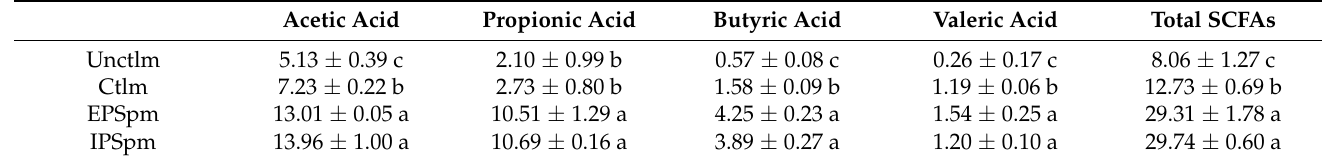
Table 3. Short chain fatty acid (SCFA) production (mM) after fecal fermentation with Cs-4 EPSp and IPSp (5 mg/mL). Unctlm: fecal fermentation basal medium before fecal fermentation. Ctlm: fecal fermentation basal medium after fecal fermentation; EPSpm: EPSp after fecal fermentation; IPSpm: IPSp after fecal fermentation. n = 3, ANOVA, different letters indicate significant difference among different groups for the same SCFA, p < 0.05.